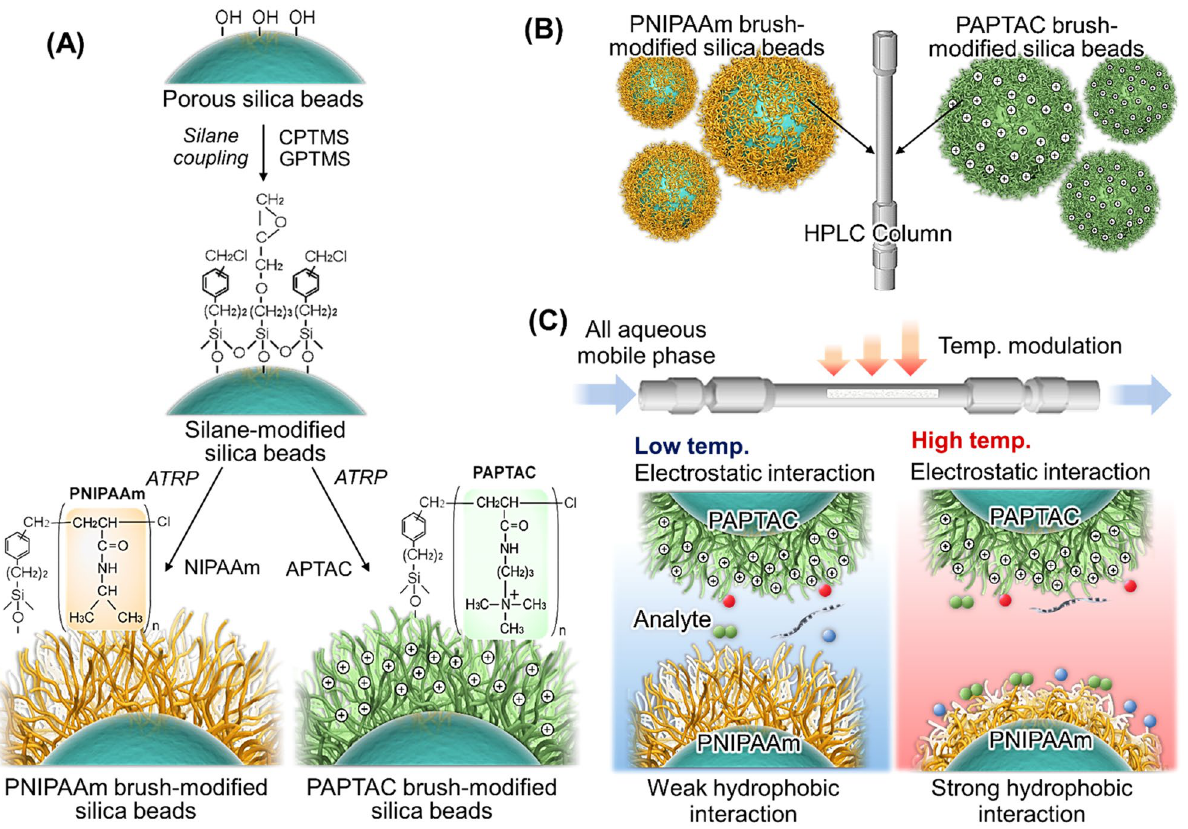
Figure 1. Temperature-responsive mixed-mode column using thermoresponsive-polymer-modified beads and cationic-polymer-modified beads. Schematic illustration of the ( A ) preparation of PNIPAAm (left) and PAPTAC (right) brush-modified beads, ( B ) preparation of the mixed-mode column by packing two types of beads, and ( C ) multiple types of interactions with the analyte. (Figures were drawn Microsoft PowerPoint 2019 Version